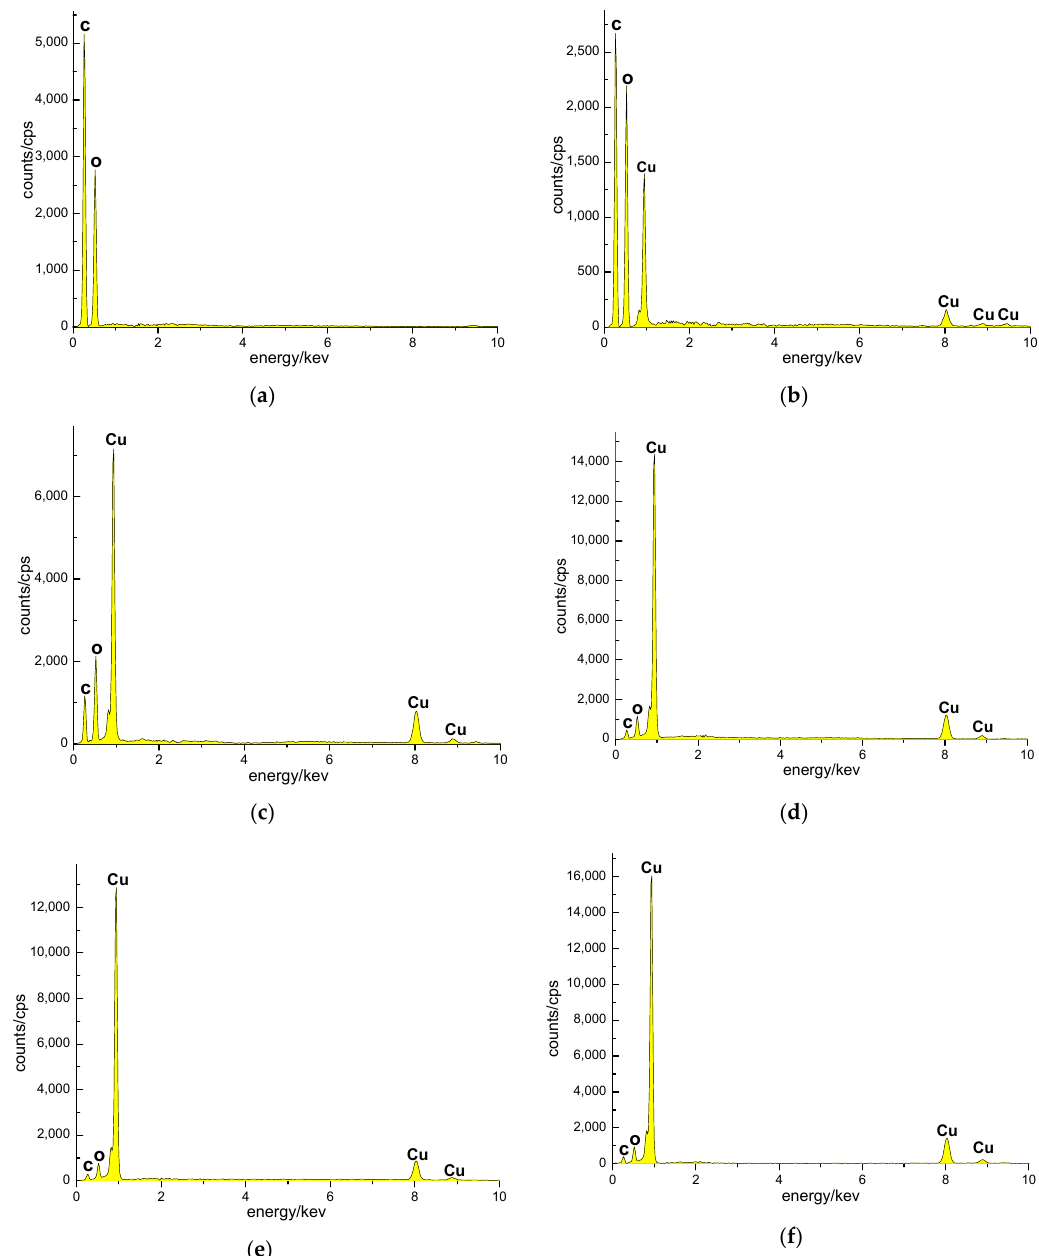
Figure 8. EDS map of copper-plated wood veneer, (a) Ultrasonic treatment wood; (b) Magnetron sputtering for 50 s; (c) Magnetron sputtering for 150 s; (d) Magnetron sputtering for 10 min; (e) Magnetron sputtering for 15 min; (f) Magnetron sputtering for 15 min (200 °C). Table 4. Weight percentage of surface elements before and after coating.